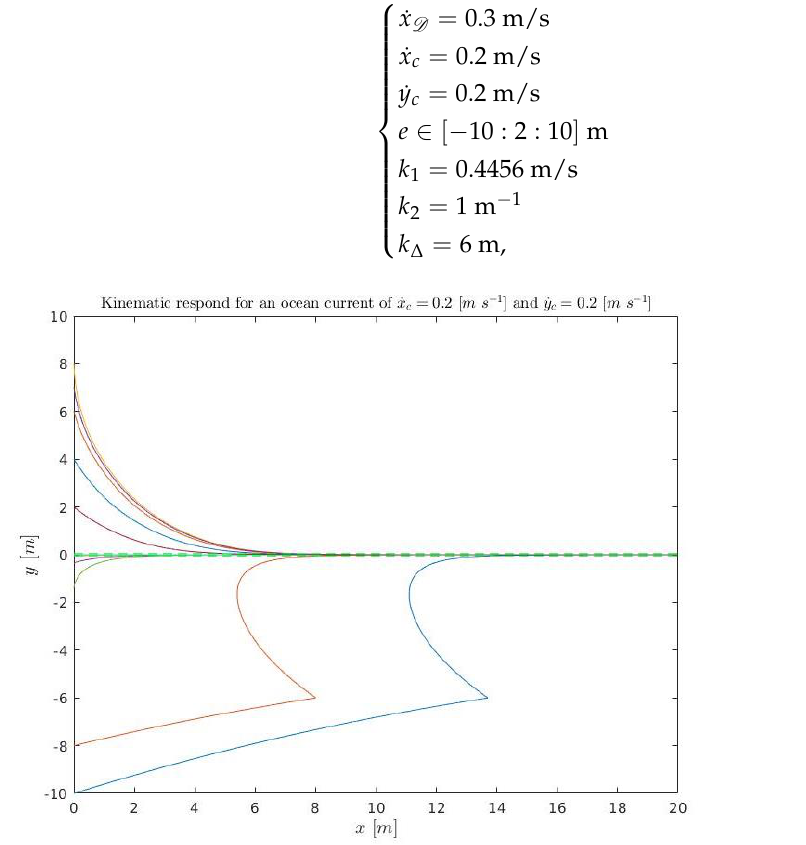
Figure 15. Kinematic simulation for the conditions (36) relative to position. The colored lines represent the different simulations and the green discontinuous line the acceptance